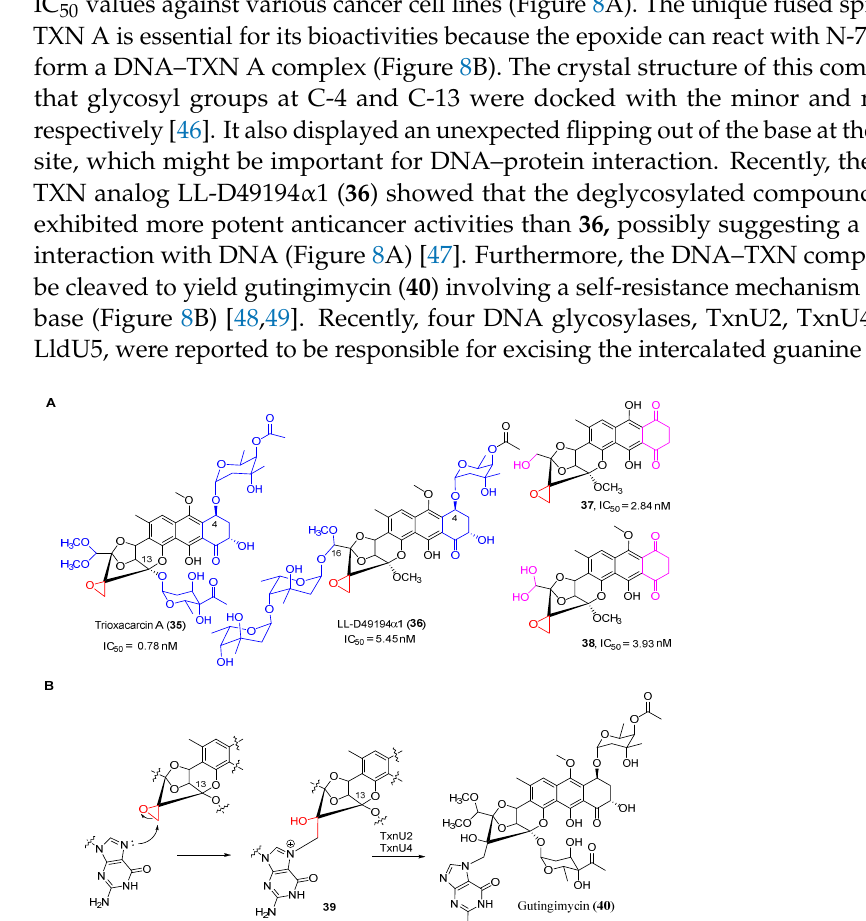
Figure 8. ( A ) Chemical structures of trioxacarcin A, LL-D49194 α 1 and their derivates. ( B ) Alkylation of DNA by